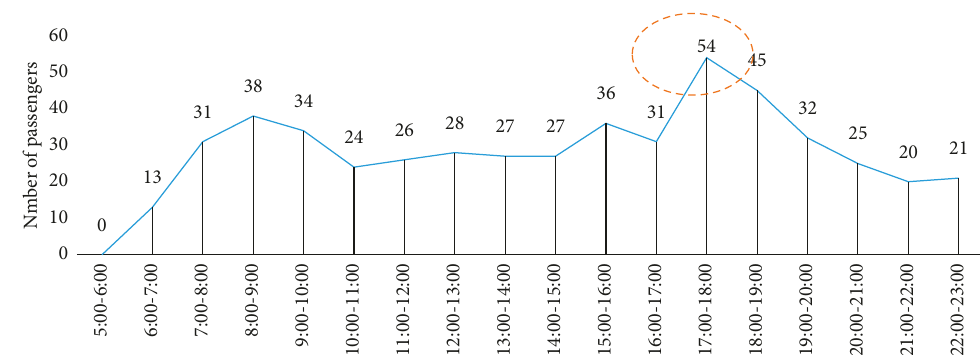
Figure 11: Passenger flow distribution of one weekend in September